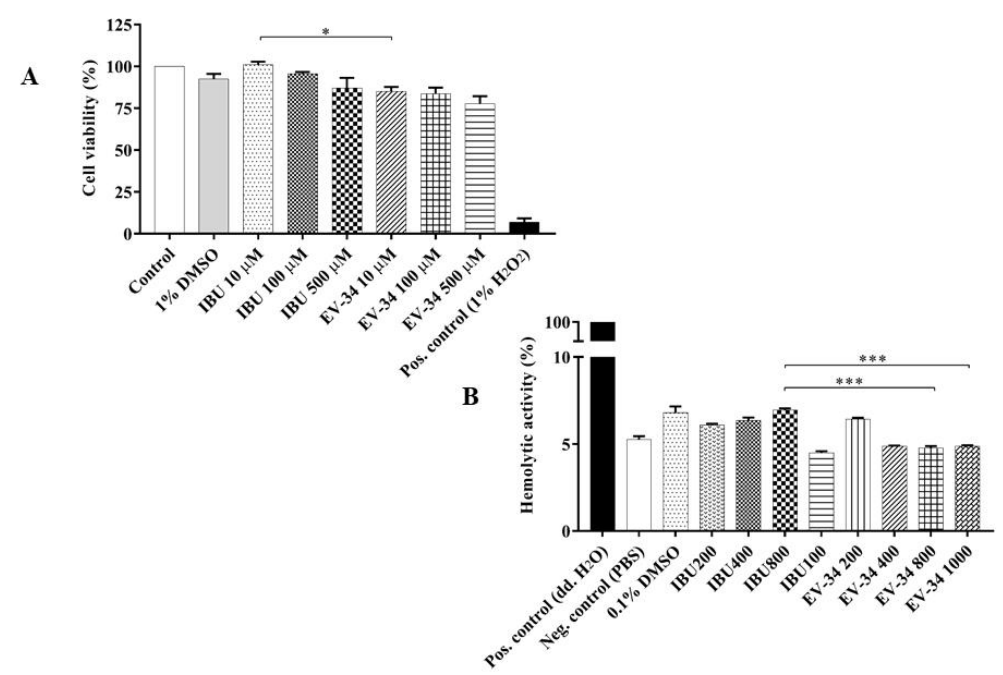
Figure 5. Safety evaluation of EV-34. ( A ) Cytotoxicity test. H9c2 cells were treated with various concentrations (10 μM, 100 μM, 500 μM for 24 h) of ibuprofen or EV-34. 1% DMSO was used as vehicle treated control. Cell viability was measured by MTT assay. Viability was reported as percentages of cell surviving ibuprofen or EV-34 exposure compared to the untreated group. The measurements were carried out in quintuplicate. Data are expressed as the mean ± SEM ( n = 6); * p < 0.05. ( B ) Hemolytic activity of ibuprofen or EV-34 on rat red blood cells. Hemolysis was expressed as the percentage of untreated control, which contained the solvent (PBS) only. Positive control: purified water. Analyzed concentrations of ibuprofen or EV-34 were 200 µM, 400 µM, 800 µM, and 1 mM. Data are expressed as the mean ± SEM ( n = 6); *** p < 0.001.